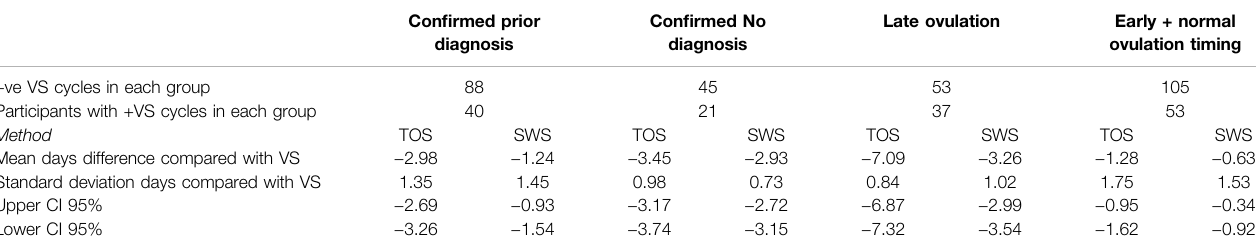
TABLE 10 | Days difference between TOS and SWS con fi rmed day of ovulation for ovulatory cycles compared with VS positive cycles for diagnosis and ovulation timing